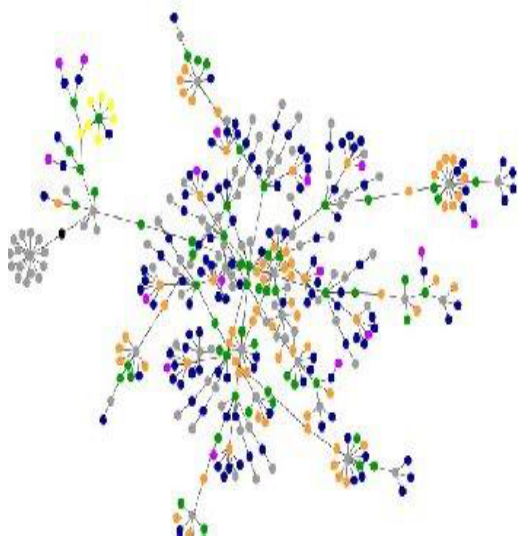
Figure 2 Boundaries between